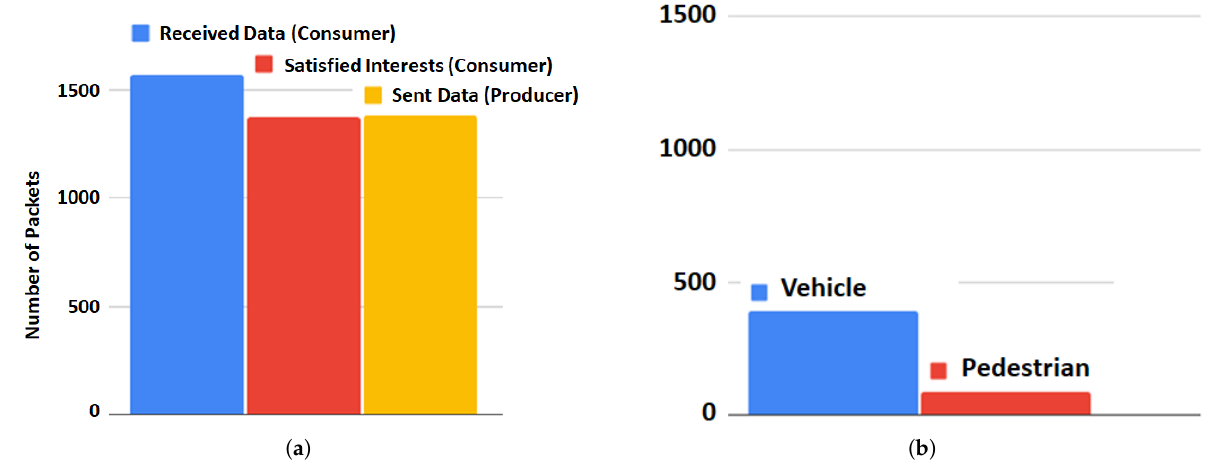
Figure 9. Network overhead. ( a ) Total amount of packets transmitted/received by the vehicle. ( b ) Total contact time between each mobile node and the